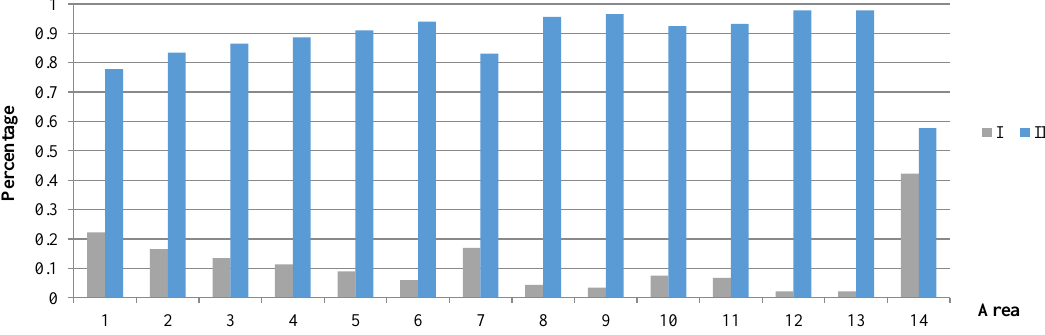
Figure 12. Time-occupation percentage of similarity computation (I) and matching-relationship identification (II).